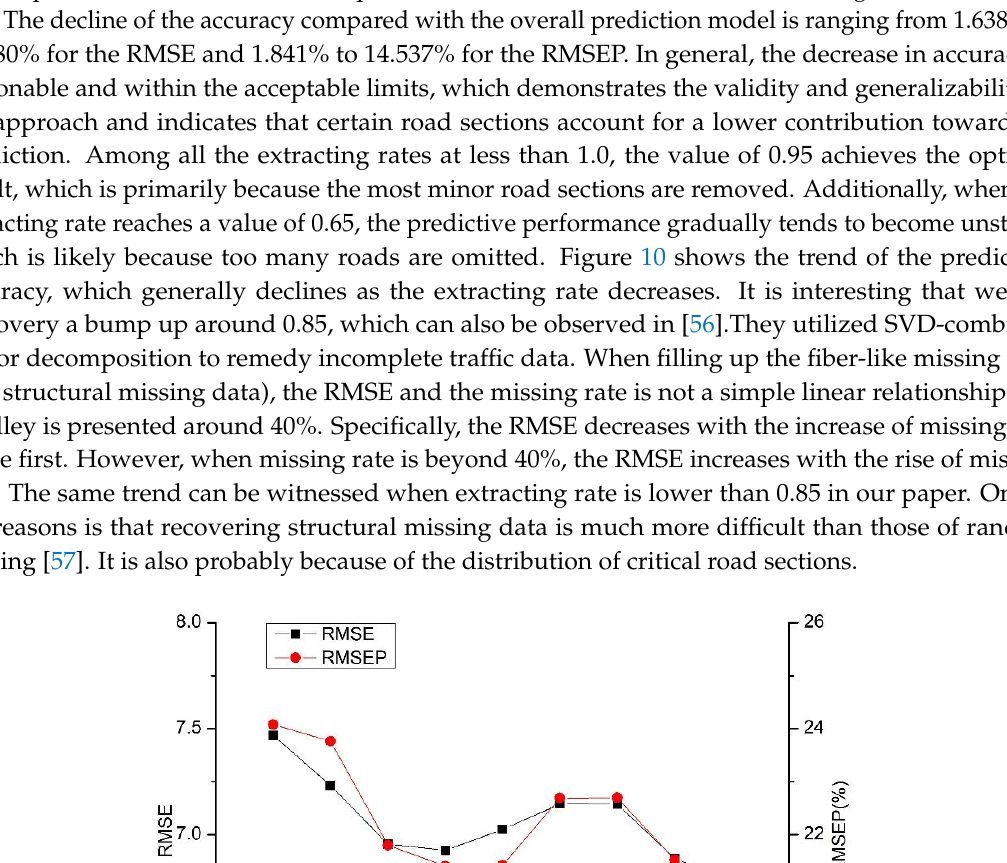
Table 5. Performance of the CRS-ConvLSTM under different extracting